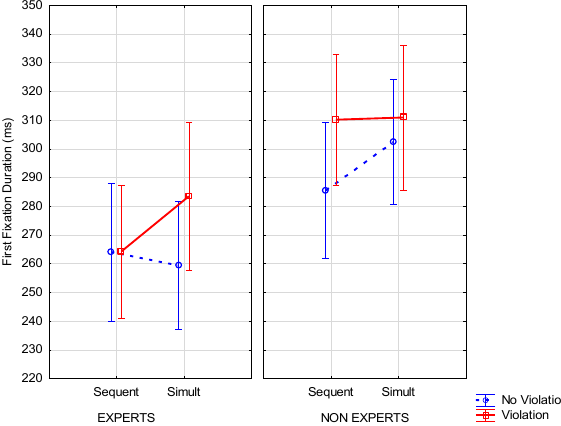
Figure 6. Error rate (%) according to expertise, note modification and presentation (error bars represent standard error).